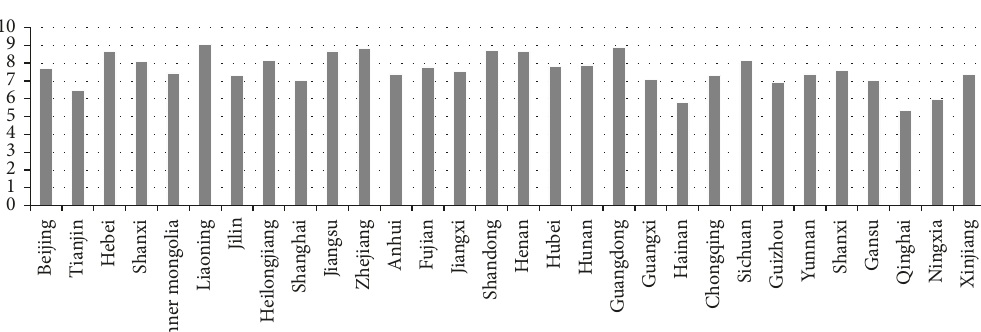
Figure 2: The average value of command-and-control environmental regulation (2006–2016).